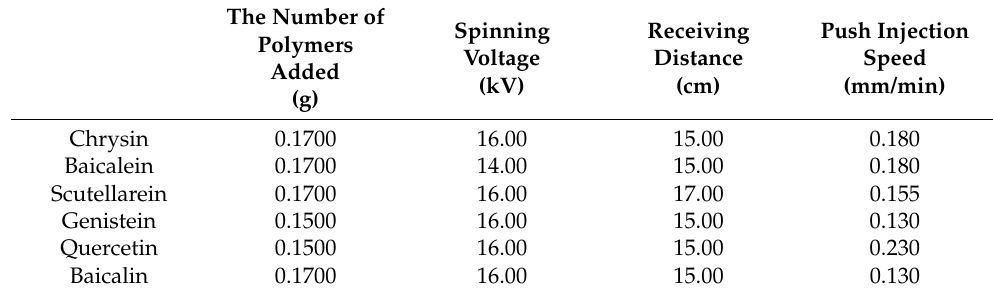
Table 1. Table of optimal conditions for preparing an electrospinning film of active Table 1 . Table of optimal conditions for preparing an electrospinning film of active molecules. The Number of